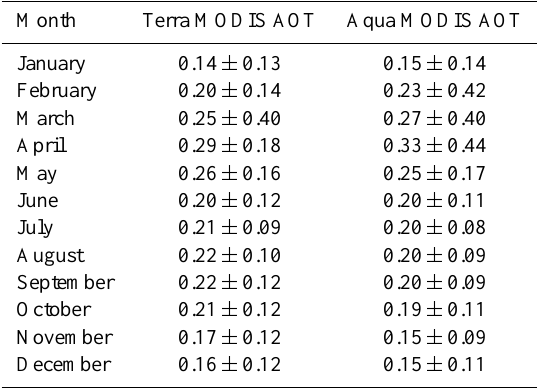
Table 4. Monthly mean AOT and standard deviation from Terra and Aqua MODIS, calculated for the period